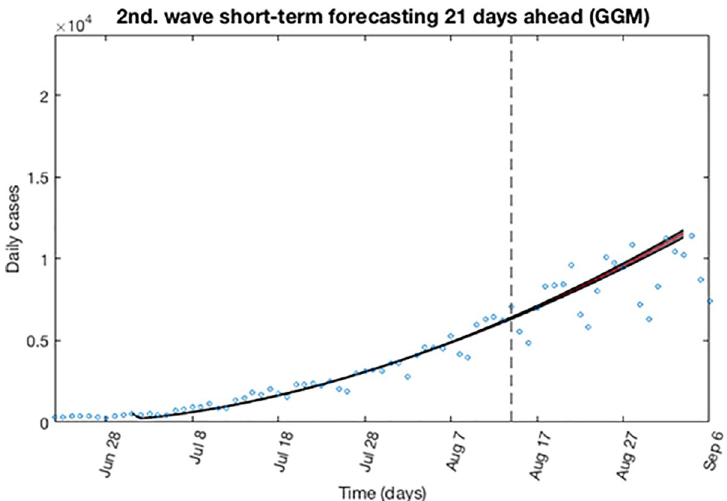
Fig 11. Short-term forecast curves for GLGM for the second wave using 300 bootstrap realizations. The red line corresponds to the best fit of the forecasted epidemic curve. The black lines correspond to the 95% confidence bounds around the best fit of the forecasted curve, and grey lines correspond to the m bootstrapping realizations of the forecasted epidemic curves. The calibration period is separated from the forecast period with a vertical slashed grey